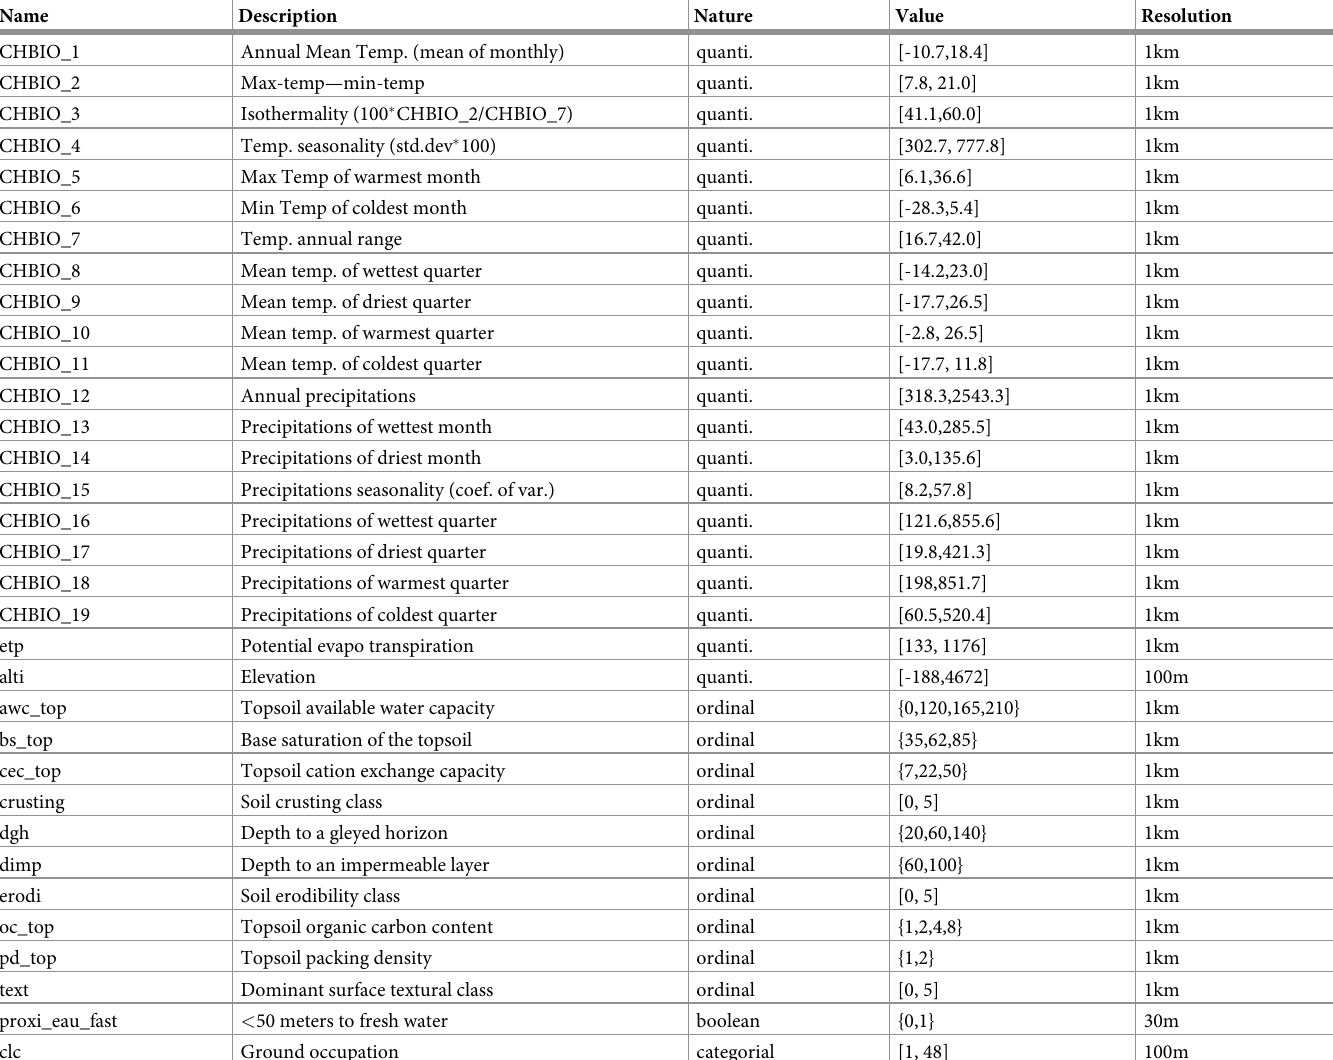
Table 1. Environmental variables and